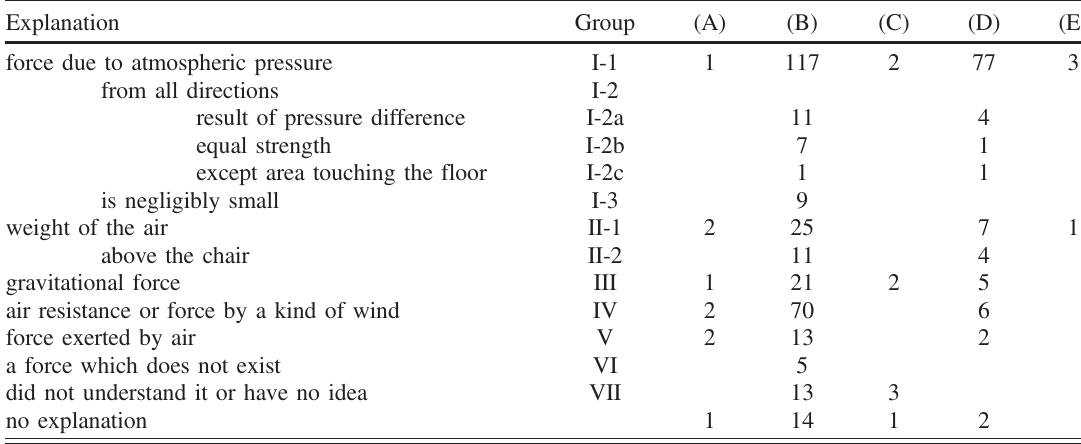
TABLE V. Groups of students ’ explanations and their responses to Q.29.